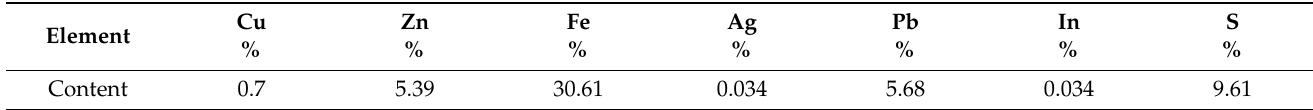
Table 2. Element content values (wt% dry basis) for the jarosite